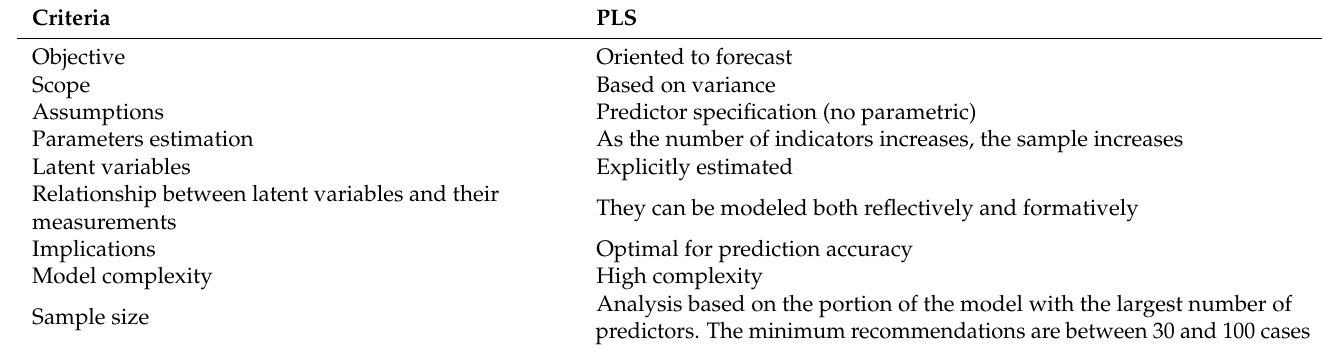
Table 4. Summary of the PLS a tt ributes (Adapted from Cepeda and Roldán [87]).